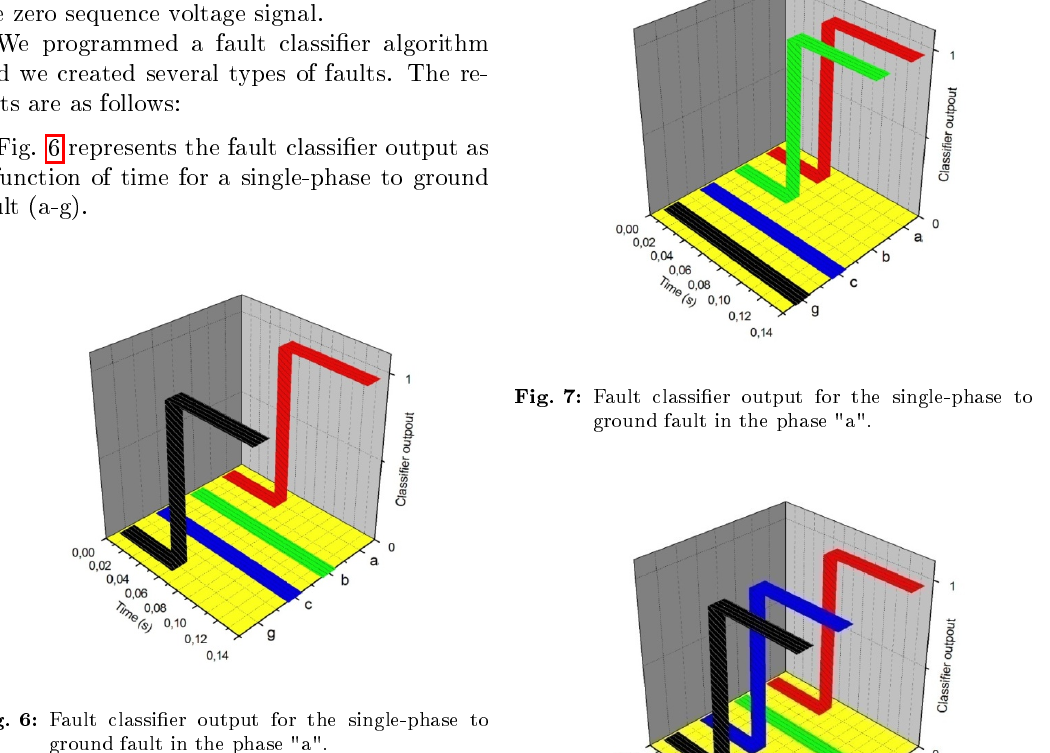
Fig. 6: Fault classi(cid:28)er output for the single-phase to ground fault in the phase "a".